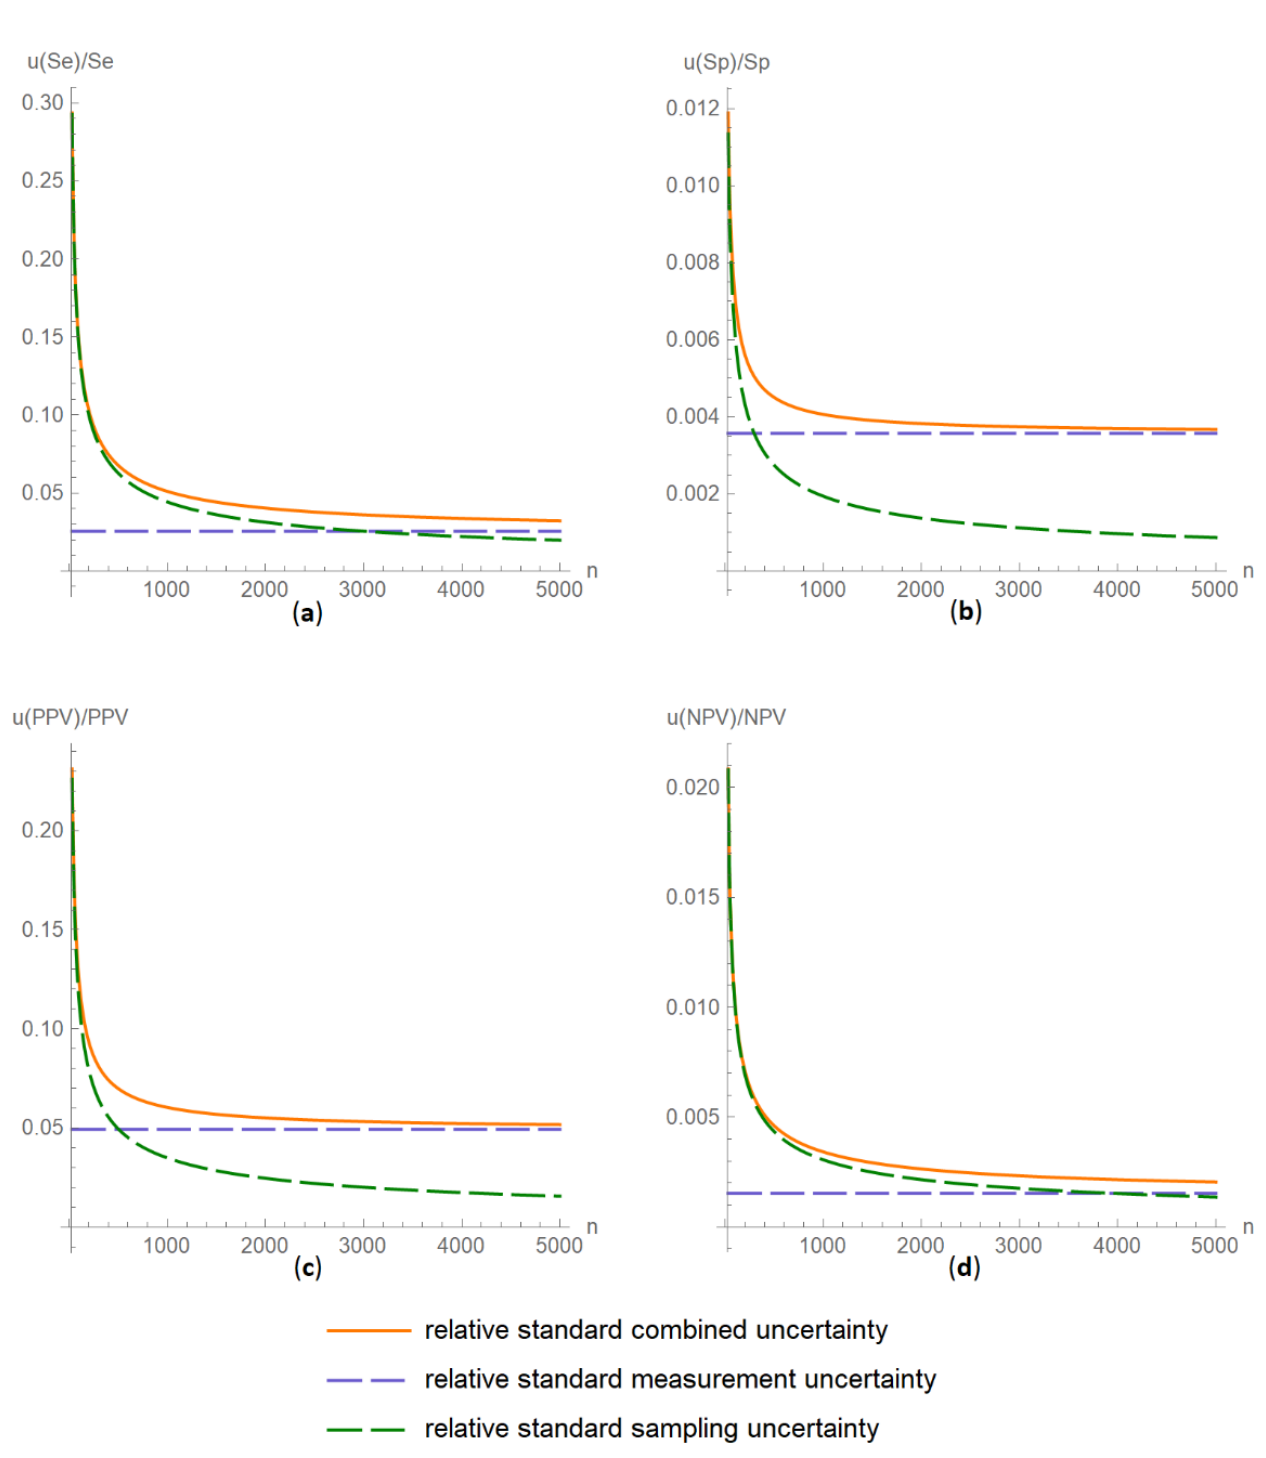
Figure 20. DAM confidence intervals versus measurement uncertainty plots. Plots of confidence intervals of ( a ) sensitivity Figure 20. DAM relative standard uncertainties versus population sample size plots. Plots of relative standard combined, ( Se ), ( b ) specificity ( Sp ), ( c ) positive predictive value ( PPV ) and ( d ) negative predictive value ( NPV ) versus standard measurement and sampling uncertainties of ( a ) sensitivity ( u(Se )/ Se ), ( b ) specificity ( u(Sp )/ Sp ), ( c ) positive predictive value ( u(PPV )/ PPV ) and ( d ) negative predictive value ( u(NPV )/ NPV ) versus total population sample size ( n ) curves, with the measurement uncertainty ( u m ) curves, with the respective parameter settings in Table respective parameter settings in Table 4.